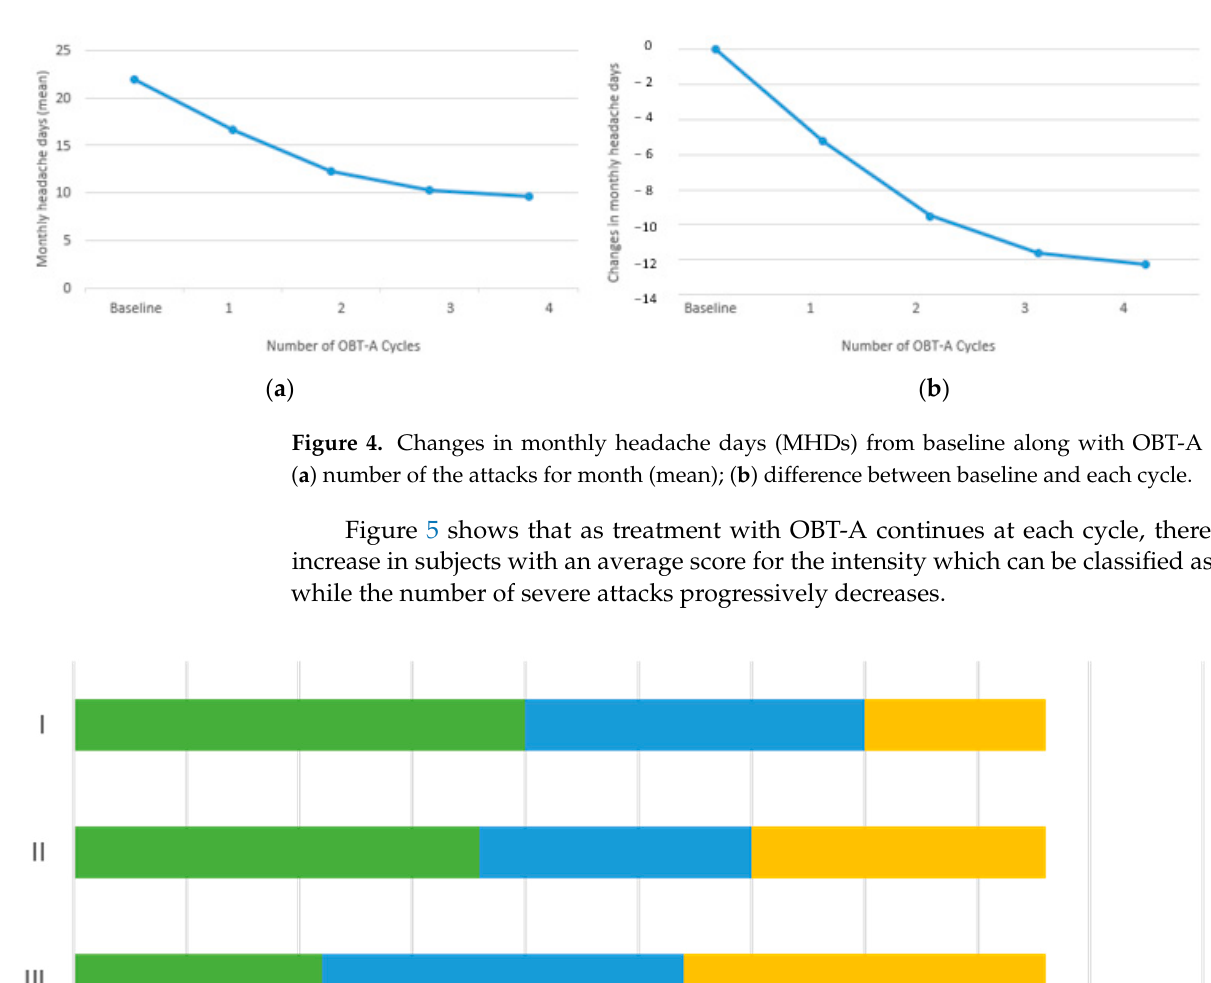
Figure 5. Frequencies of patients reporting an average of mild, moderate, or severe intensity of headache attacks for each cycle of OBT-A.